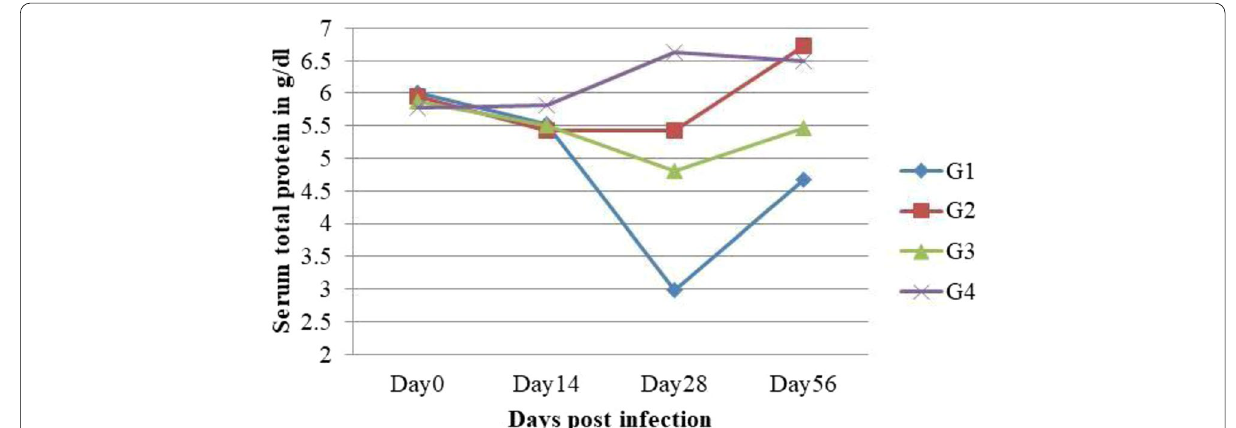
Fig. 5 Mean serum total protein concentration in infected (G1, G3) and non-infected (G2, G4) goat and sheep